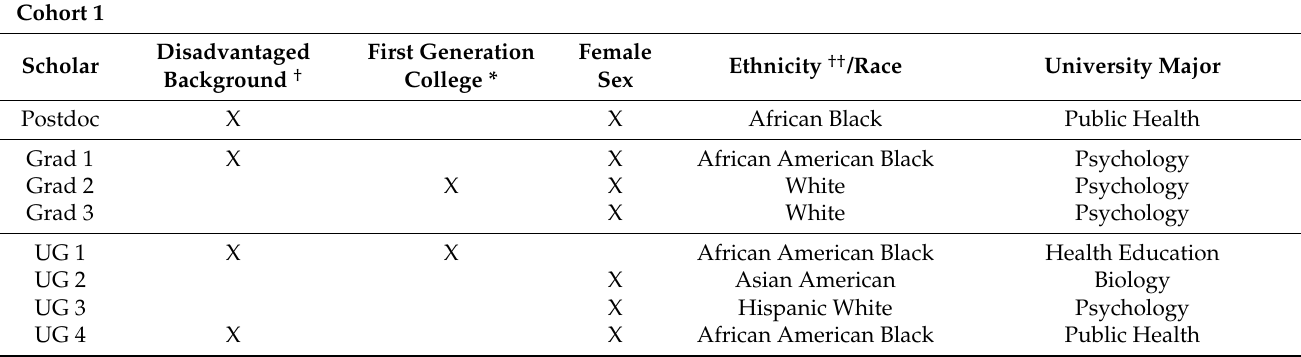
Table 1. Descriptive characteristics of the UHAND scholars ‡ —Cohorts 1 and 2